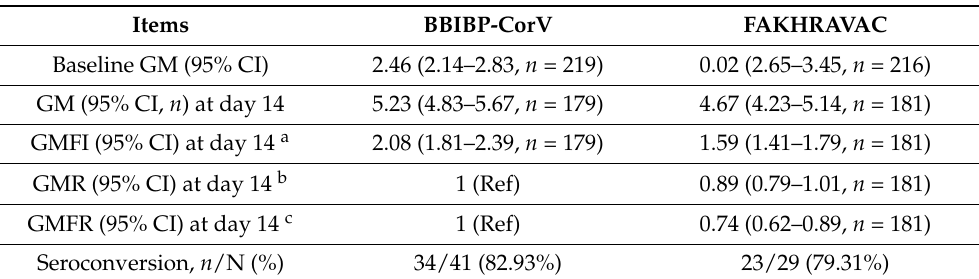
Table 5. Specific IgG antibody against S1RBD antigen indices in all participants. a The geometric mean of the amount of antibody in each vaccine was divided by the amount of antibody in the baseline (Ref) day in the same vaccine group. b The geometric mean of the amount of antibody in each vaccine was divided by the amount of antibody in the BBIBP-CorV (Ref) group on the same day. c The ratio of the geometric mean changes of the two vaccines from the baseline (Ref) value was divided to the ratio of the changes in the BBIBP-CorV (Ref) group of baseline values.